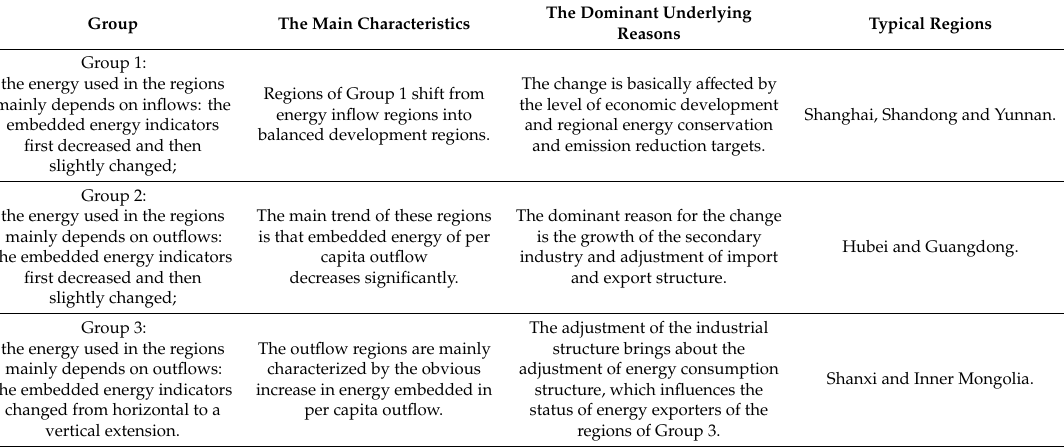
Table 3. Comparison of characteristics of three